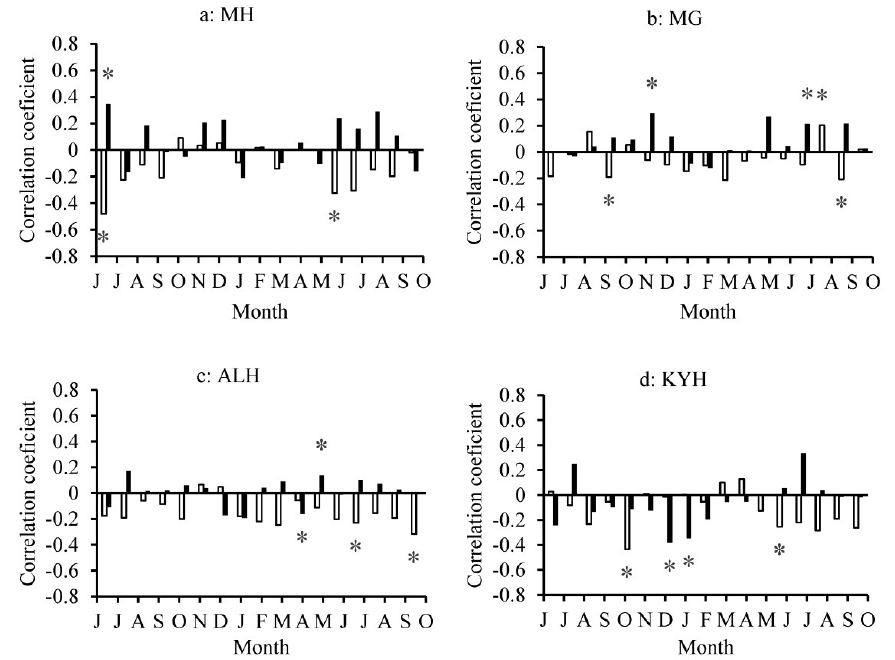
Figure 4. Correlation coefficients between the standard chronologies and total precipitation ( ■ ) and mean temperature (□) from June in the previous year to October in the current year for four sites over the period 1950–2010. The * denotes months with significant response function coe ffi cients determined from the bootstrapped response model.